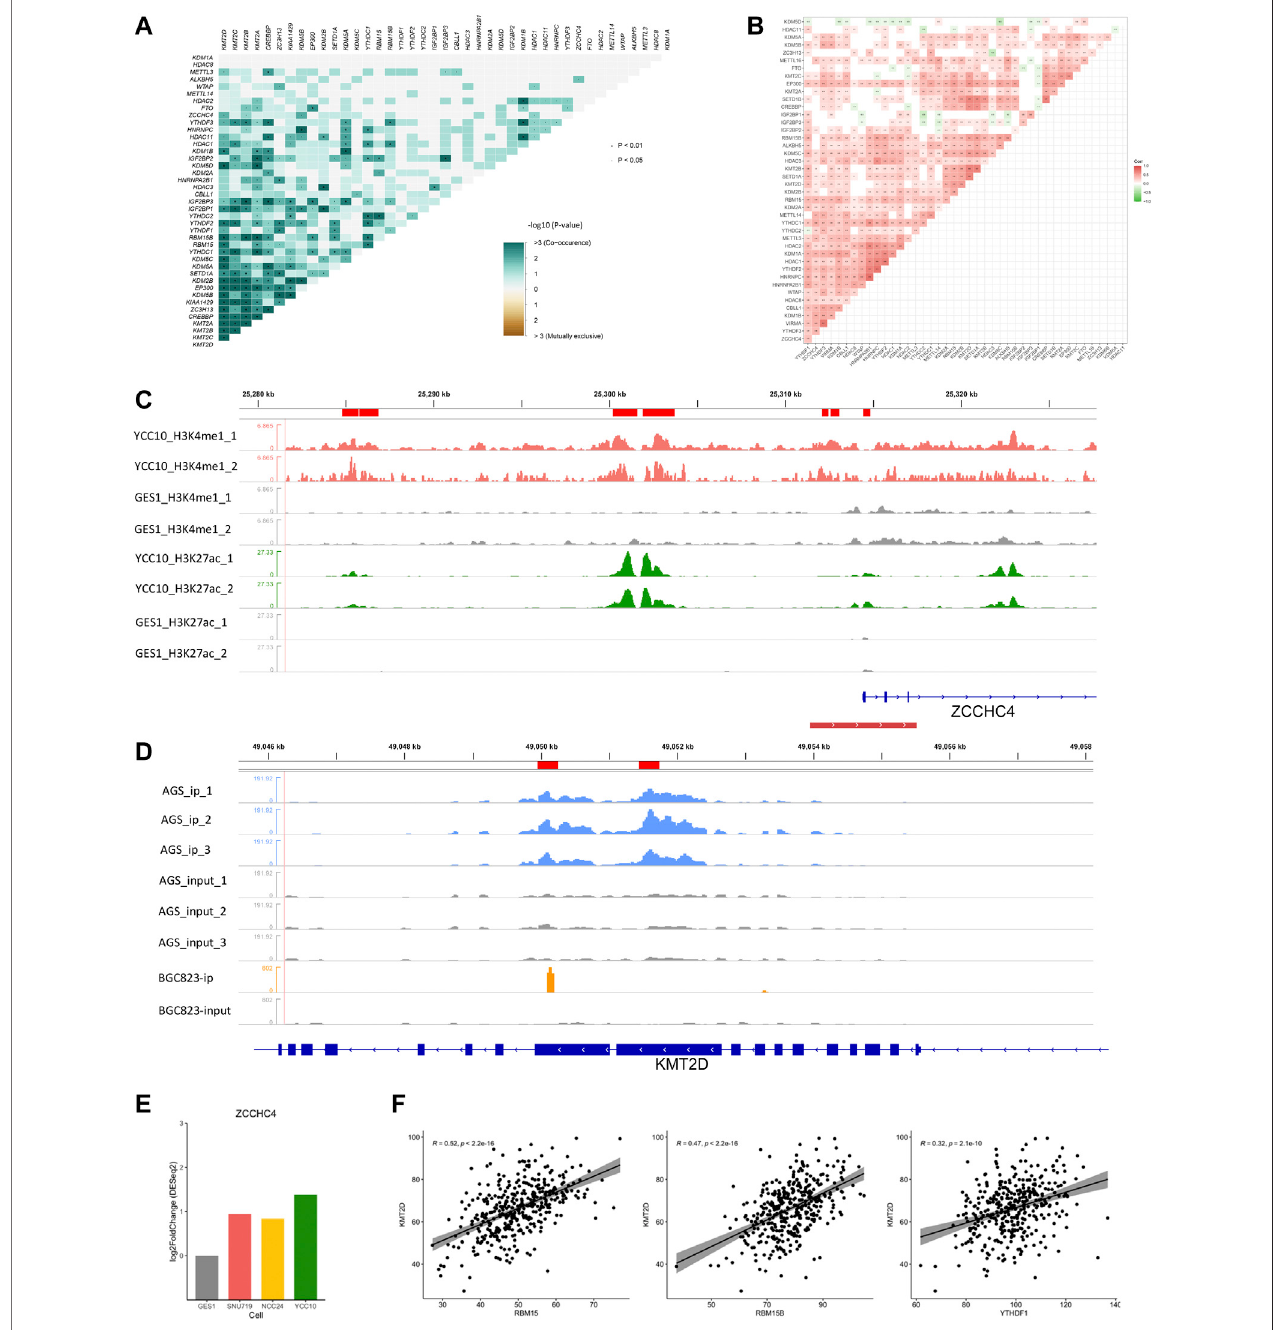
FIGURE2| Crosstalkbetweenregulatorsofhistoneandm6Amodi fi cations. (A) Co-mutation heatmapofepigeneticregulatorsintheTCGA-STAD cohort. (B) Co- expression heatmap of epigenetic regulators in the TCGA-STAD cohort. (C) Differential H3K4me1 and H3K27ac modi fi cations in the m6A regulator ZCCHC4. Peaks in redandgreenrefertotheH3K4me1andH3K27acmodi fi cationsinGCcelllines,respectively,andgrayreferstothecorrespondingmodi fi cationinGES-1ascontrol.The redlineatthebottomreferstothepromoterregion. (D) Differentialm6Amodi fi cationinthehistonemodi fi cationregulatorKMT2D.Peaksinblueandorangereferto the immunoprecipitation (IP) signals of AGS and BGC823 cell lines, respectively. Peaks in gray refer to the corresponding input signals. (E) Differential expression of ZCCHC4 between GC cell lines and GES-1 ( p < 0.05). (F) Correlations of KMT2D with the m6A regulators including RBM15, RBM15B, and YTHDF1 (Spearman, p < 0.05).